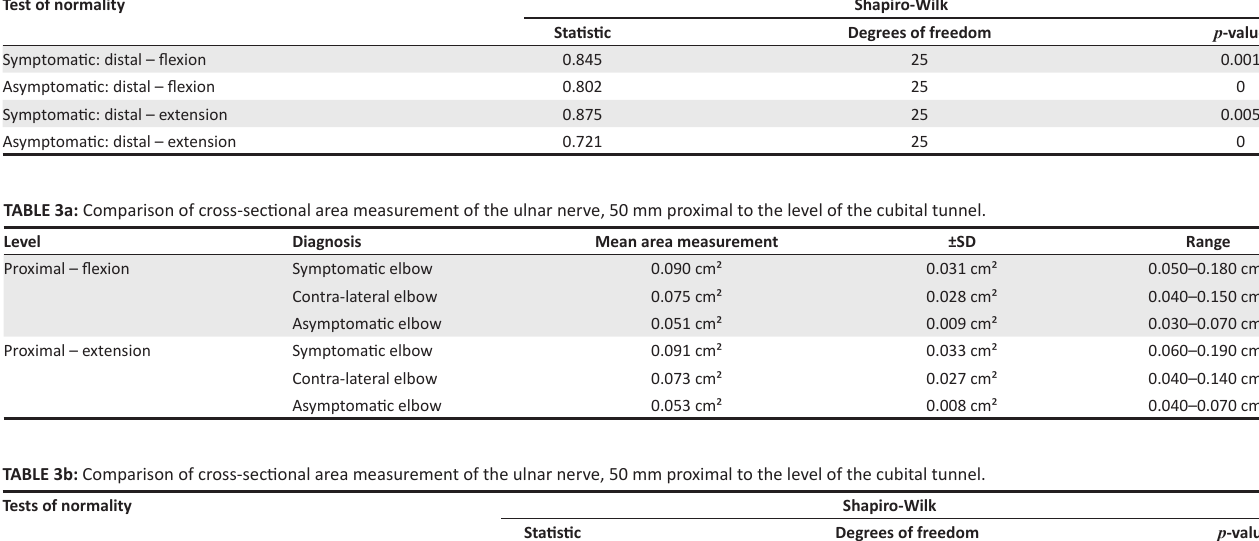
TABLE 2b: Comparison of cross-sectional area measurements of the ulnar nerve, 50 mm distal to the level of the cubital tunnel. Test of normality